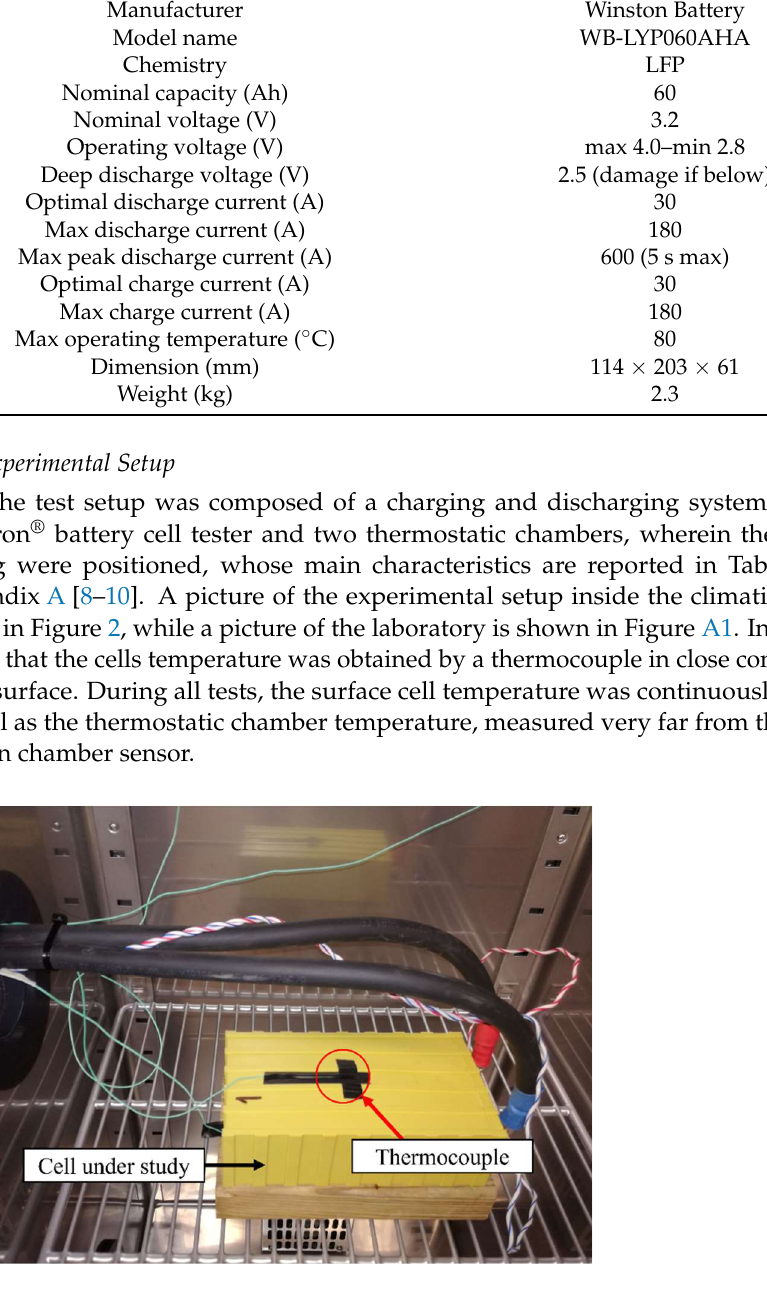
Figure 2. Picture of the cell under test inside the climatic chamber.